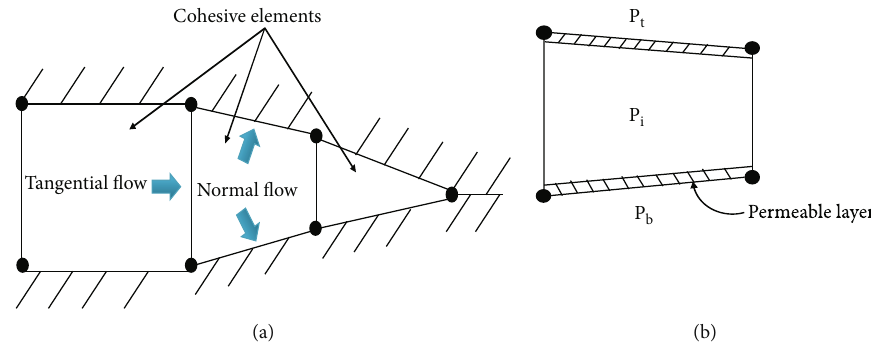
Figure 1: Schematic diagrams of seepage fl ow patterns within a cohesive interface: (a) tangential fl ow and normal fl ow; (b) fl uid leak-o ff and P are the fl uid pressure at the top and bottom fracture surface, respectively. coe ffi cient, where P t b